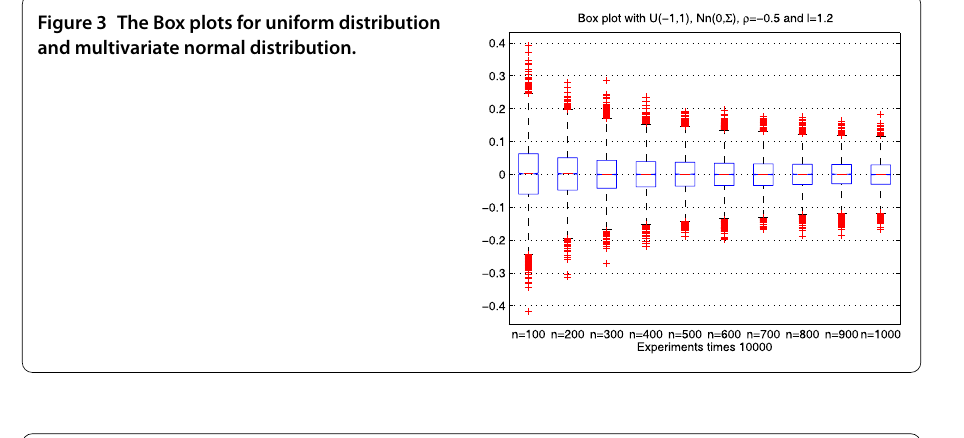
Figure 4 The Box plots for uniform distribution and multivariate normal